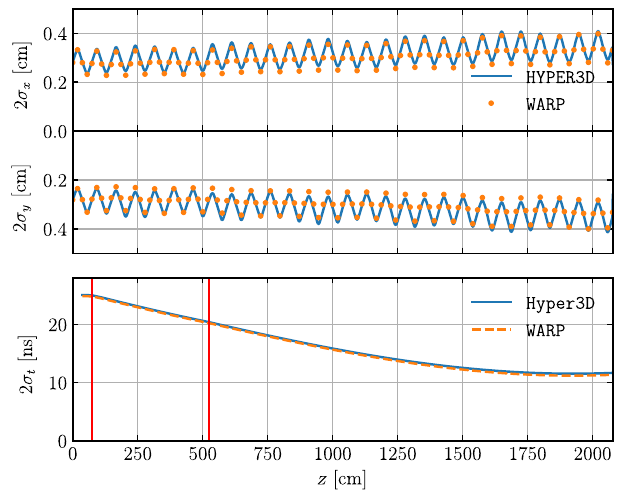
FIG. 2. The 2 rms beam envelope, over the bunching FODO lattice periods for different codes. The bunchers are centered at the locations indicated by the vertical lines.